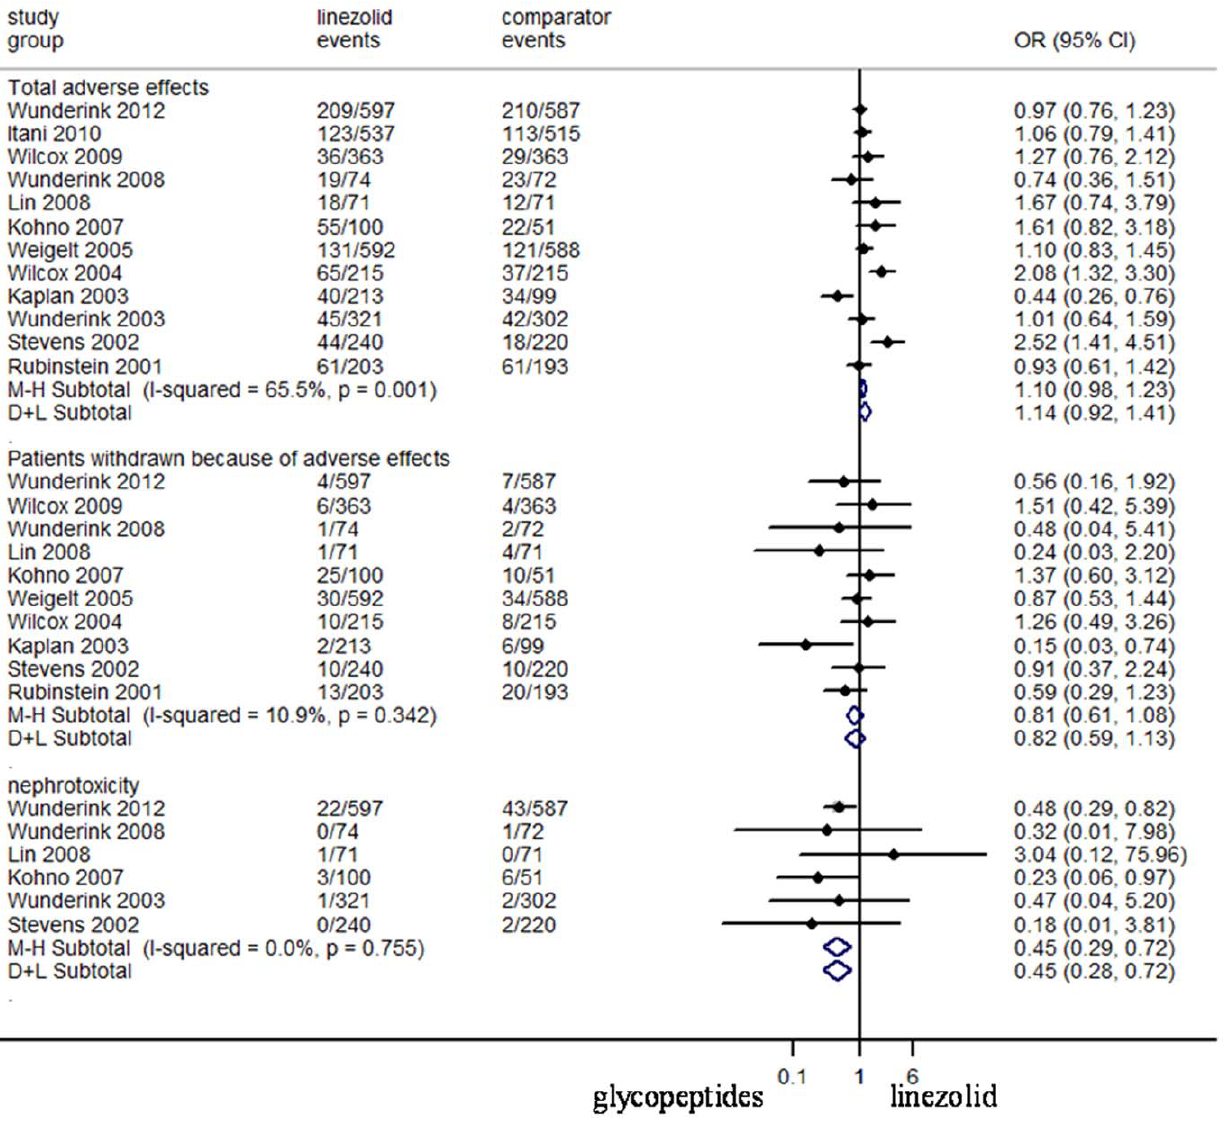
Figure 5. Meta-analyses of adverse effects related to studied regimens. Test of total adverse effects for overall effect: Z=1.58 P =0.113; test of patients withdrawn because of adverse effects for overall effect: Z=1.41 P =0.159; test of nephrotoxicity for overall effect: Z=3.36 P =0.001.